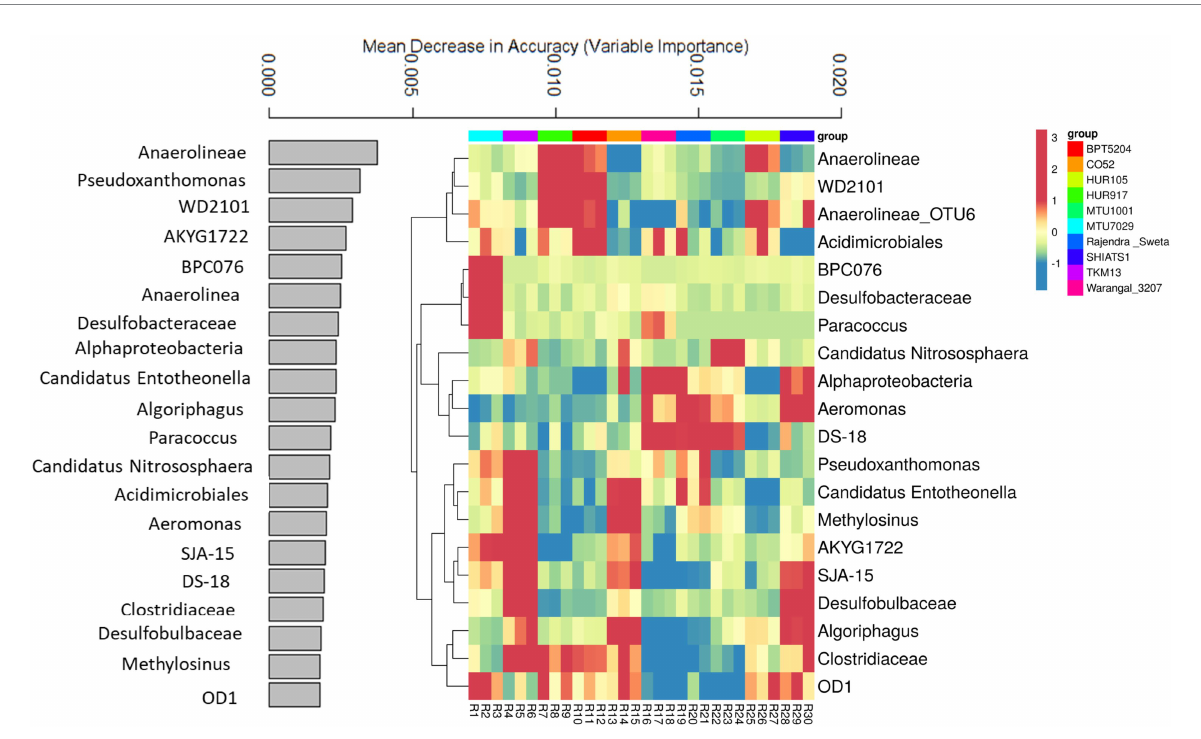
FIGURE 6 Random forest machine learning approach to identify important bioindicator bacterial taxa associated with rhizo-microbiome of rice varieties. The bar plot was drawn for the top 20 important bacterial taxa identified by the random forest machine learning approach, the values indicate mean decrease accuracy, along with heatmap was drawn to show the relative distribution of these bacterial taxa in the rice variety rhizo-microbiome, color gradient toward brown indicates high abundance whereas lighter shades represent low abundance, clustering was done based on Euclidean